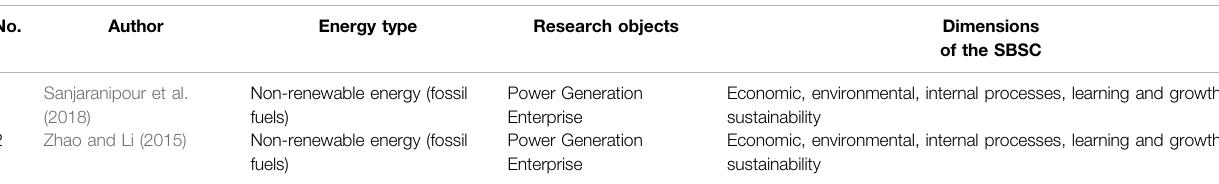
TABLE 5 | Summary of these articles using the